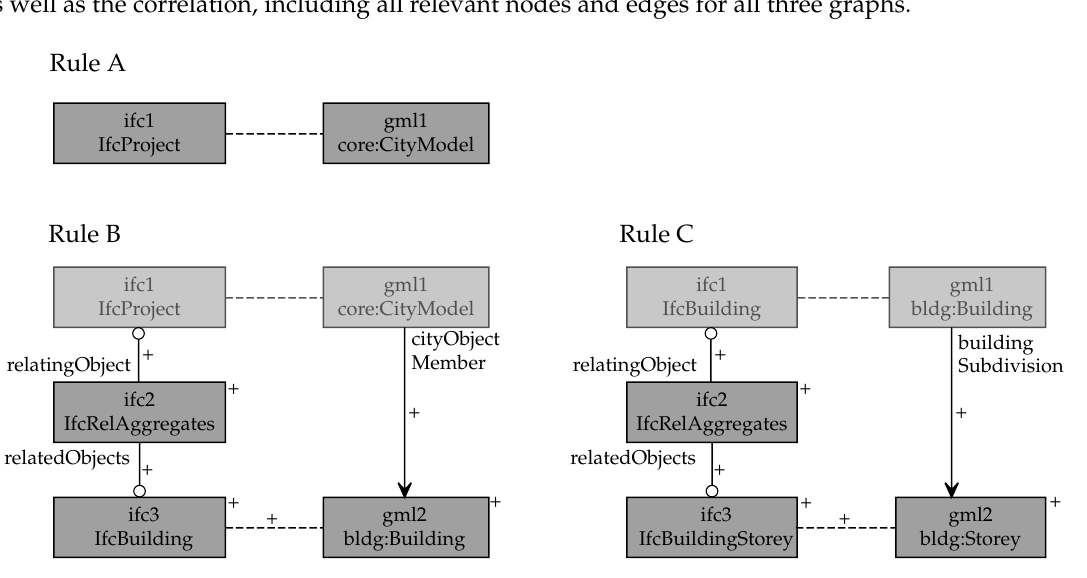
Figure 4. A grammar to create the IFC–CityGML triple graph shown in Figure 3. For each rule, the left-hand-side (indicated in grey) specifies the correlated IFC and CityGML nodes that must exist before rule application; the right-hand-side of the rule (indicated in black with a plus sign) adds correlated IFC and CityGML nodes and their connections into the existing graph